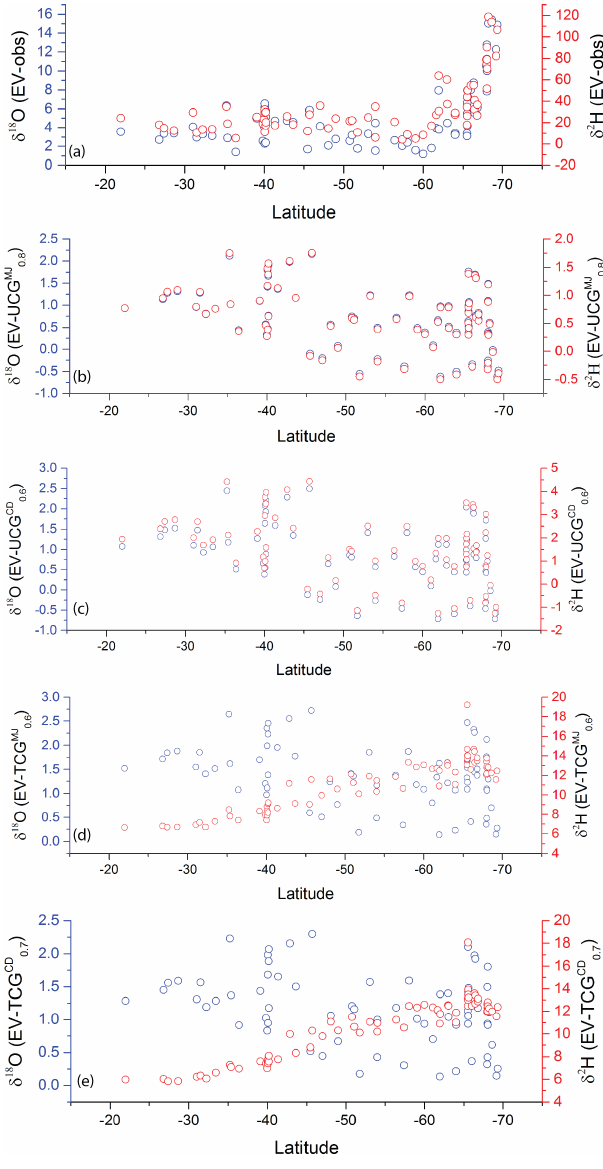
Figure 11. (a) The difference between the δ 18 O (blue columns) and δ 2 H (red open circles) of equilibrium vapor and observed water va- por isotopic composition. Panels (b) – (e) show the difference be- tween the δ 18 O and δ 2 H equilibrium vapor and that predicted by the best-fit model